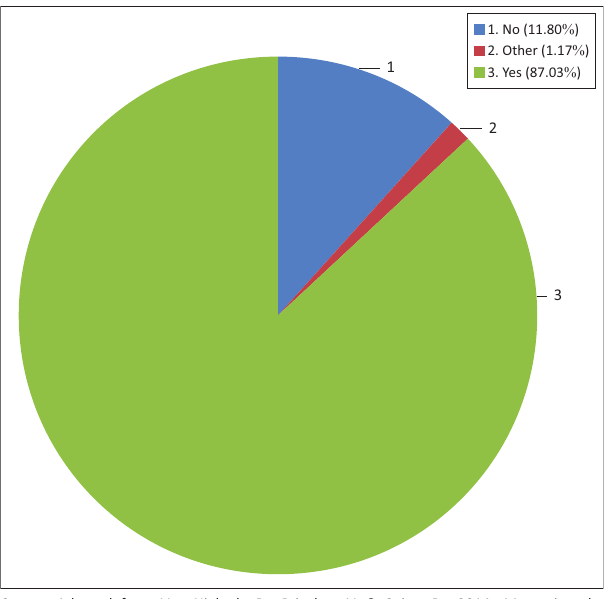
FIGURE 9: The perceived usefulness of planting after floods, using residual